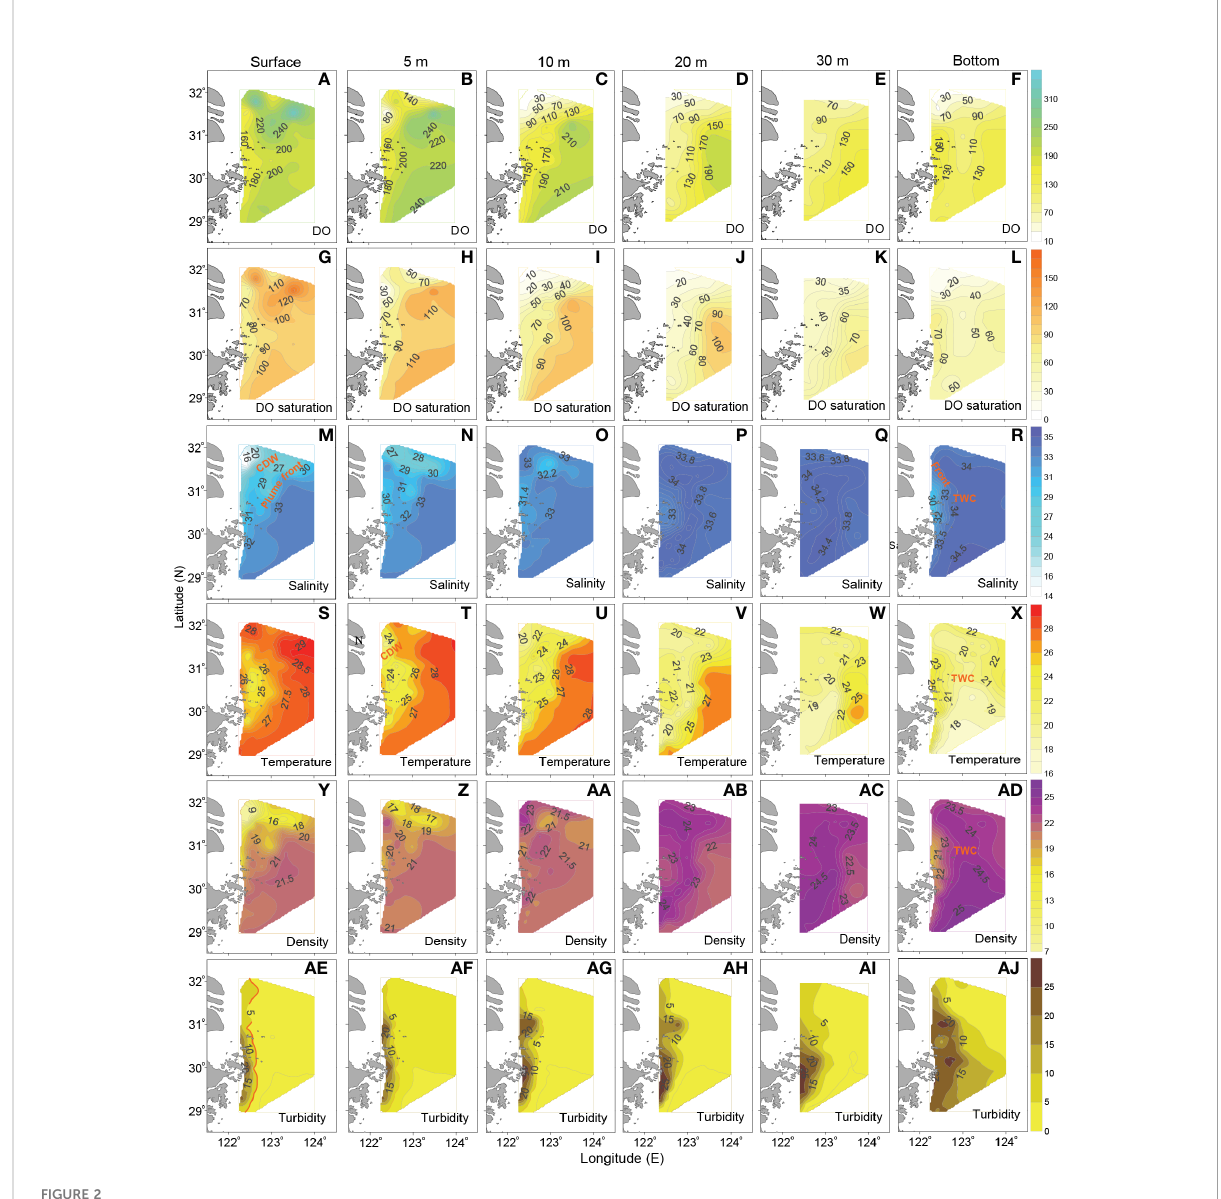
FIGURE 2 Horizontal distributions of (A – F) DO ( m mol dm -3 ), (G – L) DO saturation (%), (M – R) salinity, (S – X) temperature (°C), (Y – AD) potential density (kg m -3 ) and (AE – AJ) turbidity (NTU) off the CE in August 2013. The red line in panels (AE – AG) generally implies the location of turbidity front, where sharp gradients